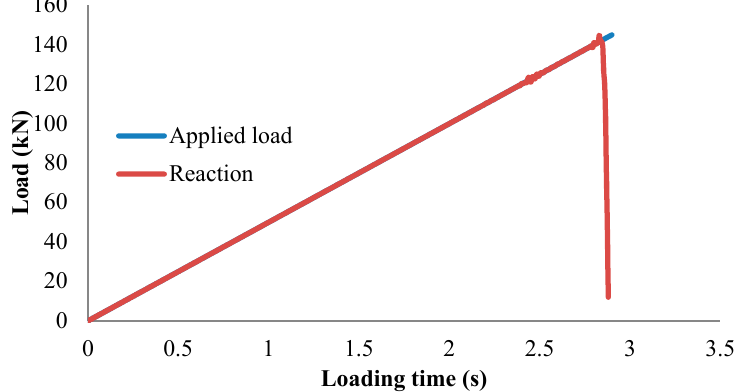
Figure 17. Applied load and reaction load vs. loading time in nonlinear finite element analysis (NLFEA) (Model S-C-2-9, Test failure load = 138 kN, NLFEA failure load = 144 kN).